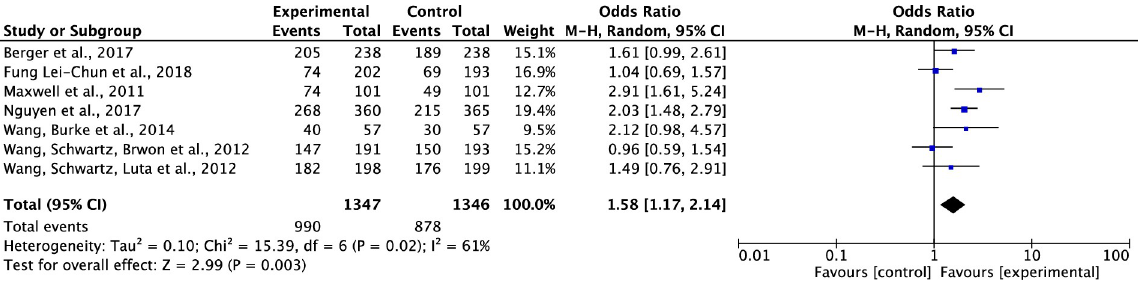
Fig 2. Forest plot of participants’ knowledge of cancer screening.